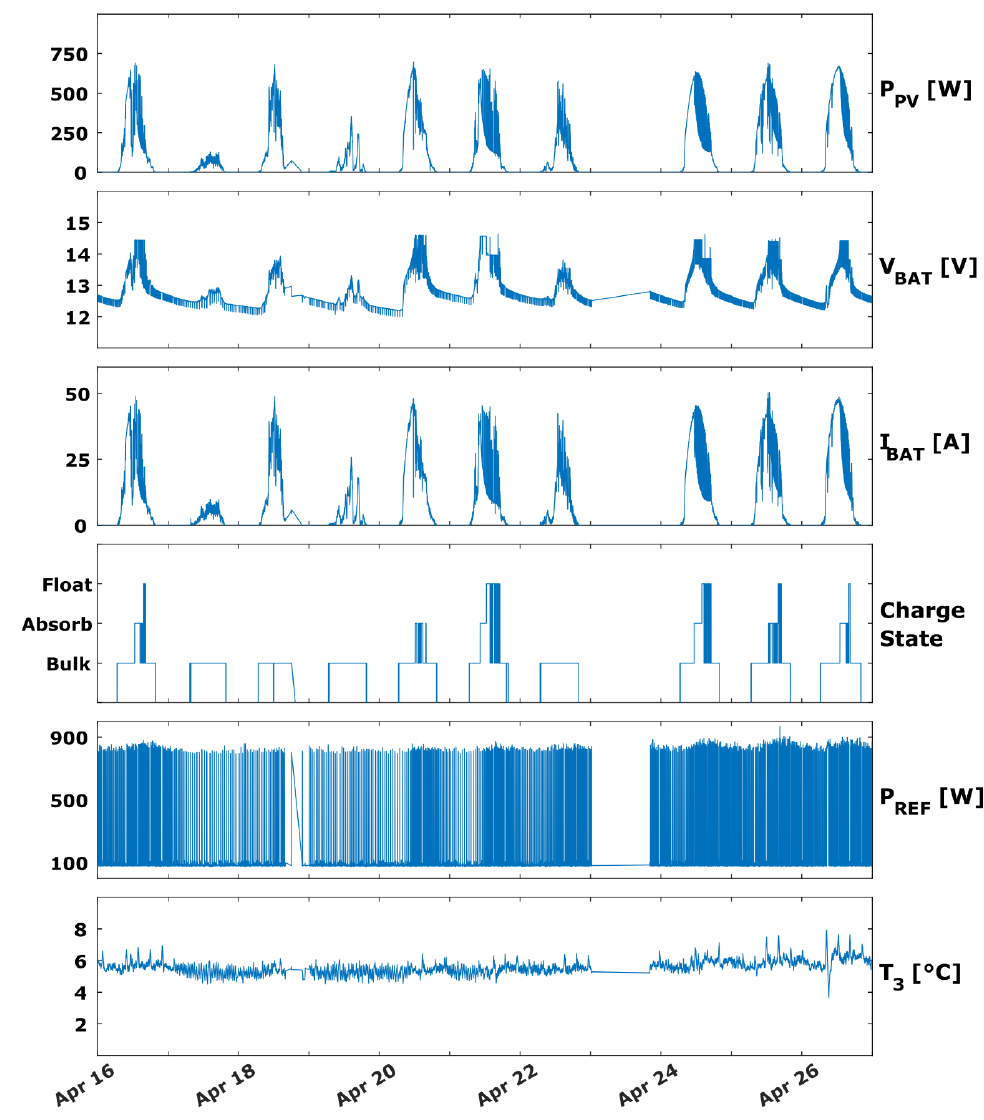
Figure 13. Data recorded by the vending machine between 16 and 26 April 2022.